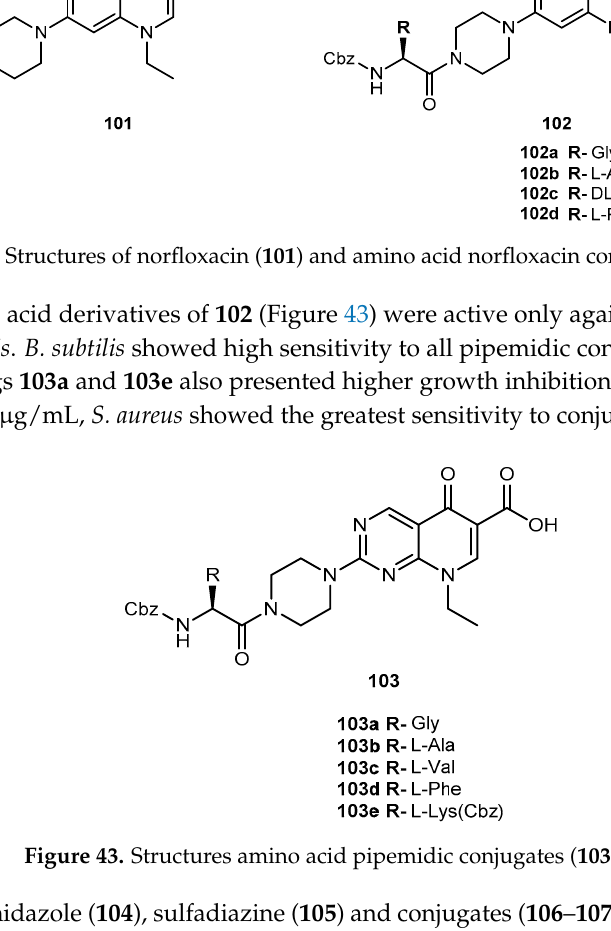
Figure 44. Structures of metronidazole ( 104 ) and its conjugates ( 106a – e) and sulfadiazine ( 105 ) and its conjugates ( 107a – c ). Ibrahimi and co-workers considered that the inclusion of amino acids in antibiotics, may provide alternative options for treatment of bacterial-resistant strains, with the benefit of increasing drug uptake and/or eliminate or alleviate adverse side effects [144]. 3.4.2. Tuberculosis (TB) The emergence of drug-resistant tuberculosis worldwide is alarming [146]. It is estimated that one-third of the world’s population is currently infected with Mycobacterium tuberculosis ( M. tuberculosis ), and every year 8–9 million new cases arise. In addition, almost 500,000 people per year are infected with multi-resistant TB (MDR-TB) and 40,000 new cases of drug-resistant TB (XDR-TB) are estimated. XDR-TB was defined as a resistance to any fluoroquinolones and to at least one of the three injectable drugs capreomycin, kanamycin or amikacin. Moreover, unlike MDR-TB, XDR-TB is often untreatable. In addition, HIV co-infection with MDR-TB in immunocompromised patients is a serious challenge. Therefore, it is urgent develop novel types of drugs or prodrugs with a new mechanism of action [147]. A novel series of halogenated salicylanilides and N -acetyl- L -phenylalanine ( 108a – k , Figure 45) were synthesized and their antibacterial activity was assessed against M. tuberculosis including MDR-TB strains and atypical mycobacteria [148].